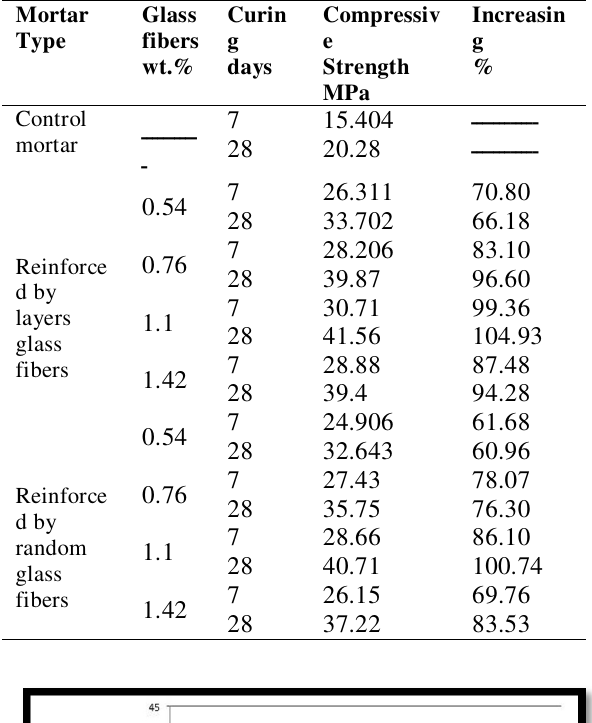
Table 9, Results of compressive strength testing for glass fibers reinforced mortar with SBR